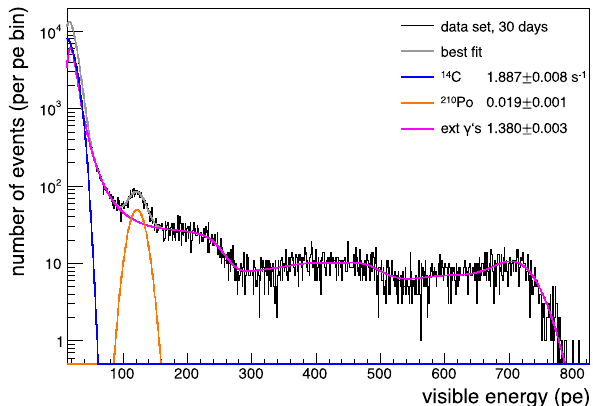
Fig. 21 Sample photoelectron (p.e.) spectrum for OSIRIS, applying a fiducial volume cut to the innermost cylindrical volume of 1m height and diameter for internal signals. The spectral contributions of 14 C and 210 Po emerge above the otherwise dominant external γ background level. Corresponding rates can therefore be extracted via a spectral fit at %-level precision. In this plot, we assume a 14 C abundance of 10 − 18 . 210 Po is set to the minimum requirement defined for JUNO solar neu- trino analysis, i.e. 80 decay per day and ton. The external background level has been determined by simulation (Sect.